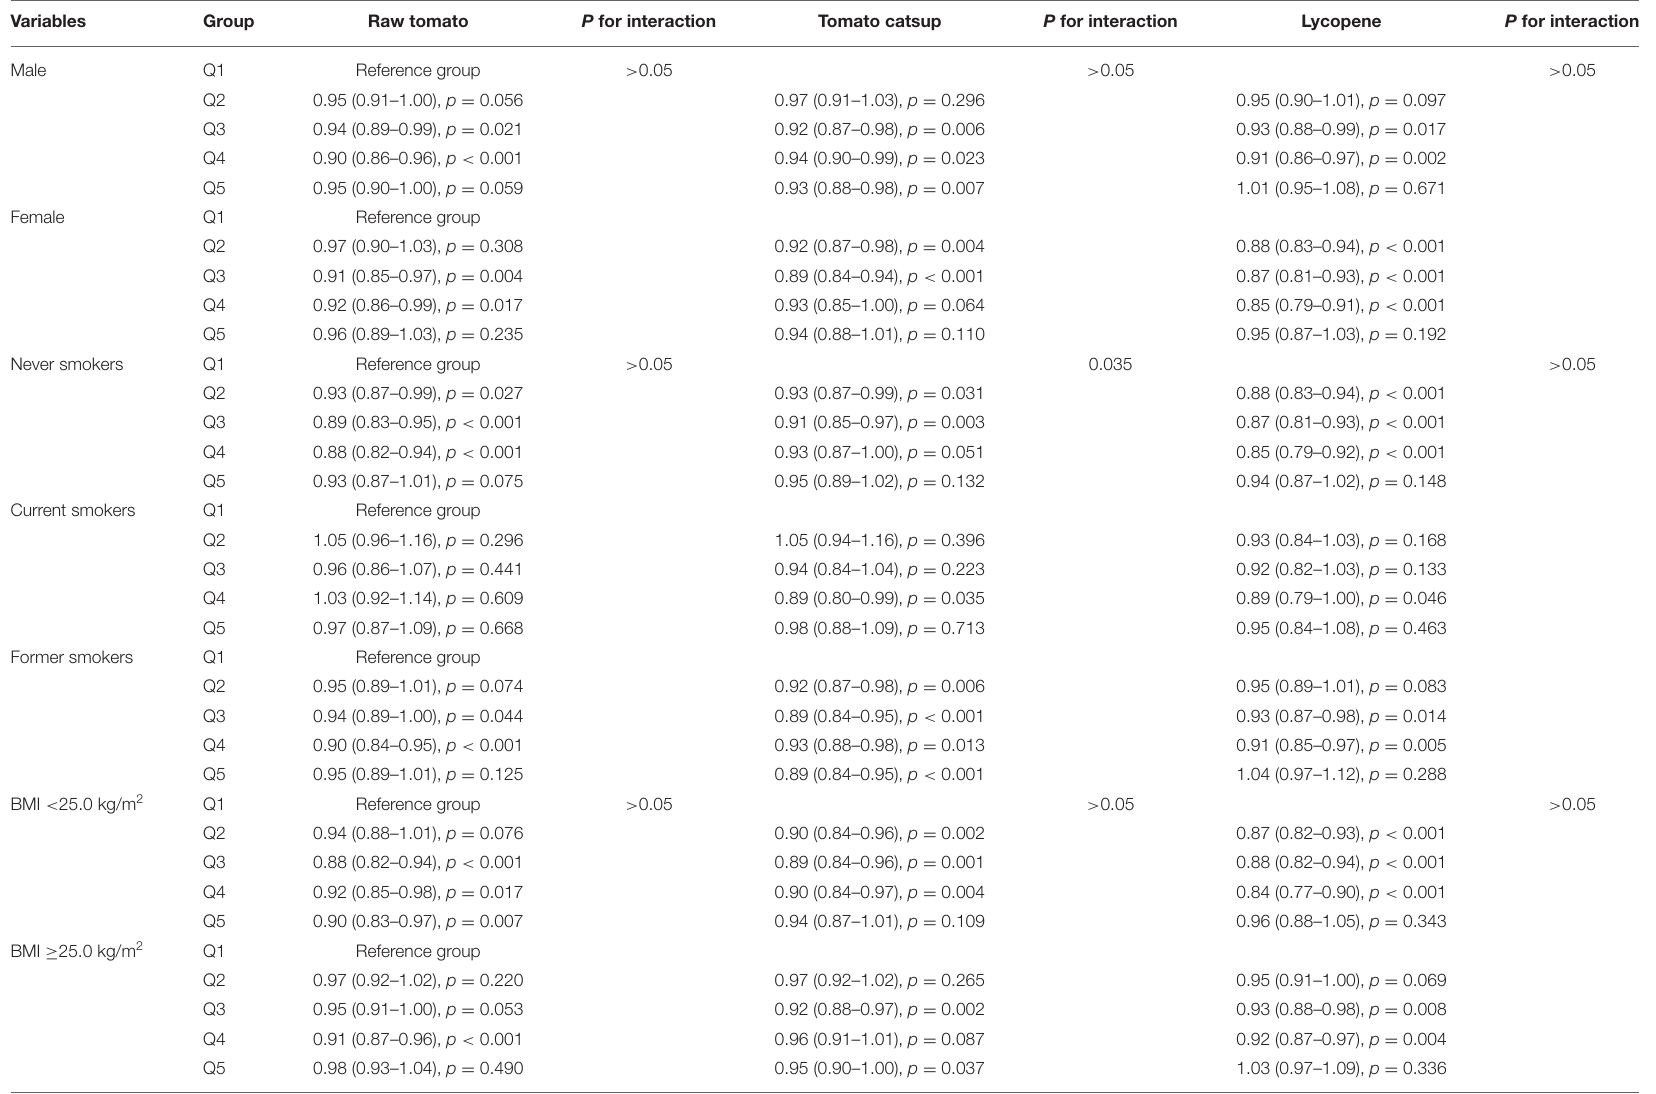
TABLE 5 | Subgroup analyses of the associations between tomato or lycopene intake and total mortality were performed based on sex, smoking status, and